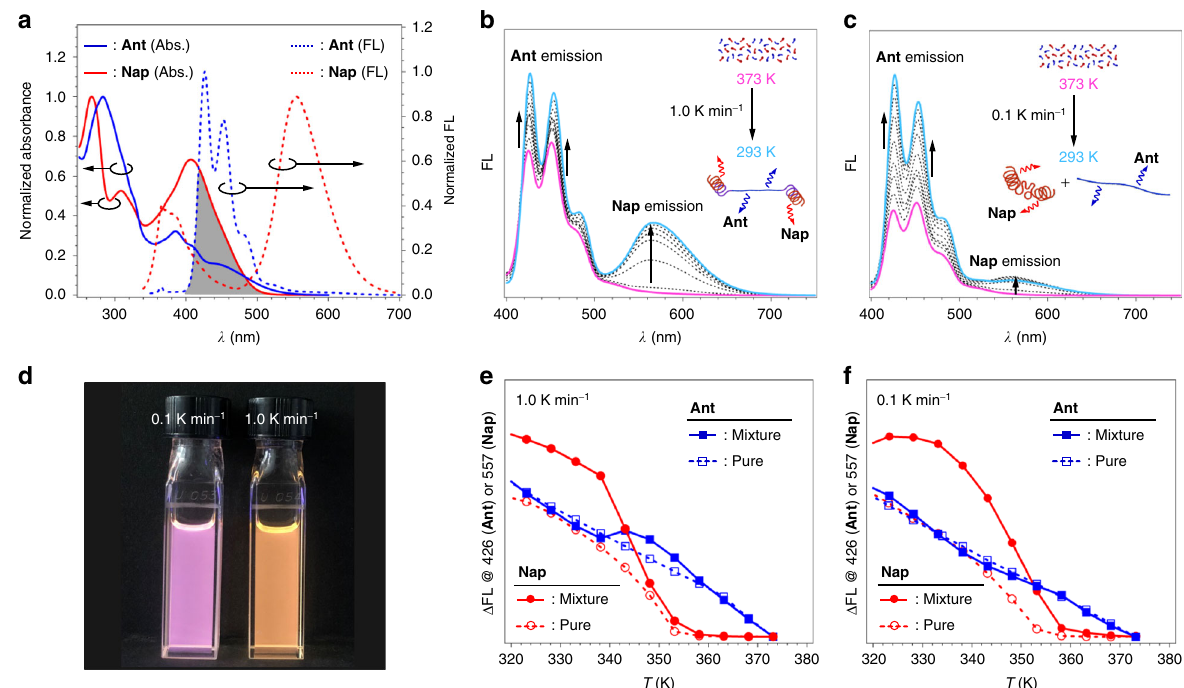
Fig. 4 Mechanistic studies on the gradient supramolecular copolymerization by fl uorescence spectroscopy. a Overlay of fl uorescence spectra and absorption spectra of Ant and Nap ( c = 1.0 × 10 − 5 M). Dotted curves: fl uorescence spectra of Ant (blue) and Nap (red) in MCH ( λ ex = 283 nm) measured after cooling from 373 to 293 K using a cooling rate of 1.0 K min − 1 . Solid curves: absorption spectra of Ant (blue) and Nap (red) in MCH measured after cooling from 373 to 293 K using a cooling rate of 1.0 K min − 1 . The gray area shows the overlap of the fl uorescence spectrum of Ant and absorption spectrum of Nap. b , c Temperature-dependent fl uorescence spectra of a 1:1.5 mixture of Ant ( c = 1.0 × 10 − 5 M) and Nap ( c = 1.5 × 10 − 5 M) upon cooling from 373 to 293 K using cooling rates of 1.0 K min − 1 ( b ) and 0.1 K min − 1 ( c ) ( λ ex = 330 nm). d Photograph of the emission of 1:1.5 mixtures prepared by cooling at 0.1 K min − 1 (left) and 1.0 K min − 1 (right). e , f Plot of the fl uorescence intensity change ( Δ FL) for Ant at 426 nm (blue) and Nap at 557 nm (red) as a function of the temperature upon cooling pure MCH solutions (open circles and squares with dashed lines) and the 1:1.5 mixure (closed circles and squares with solid lines) using a cooling rate of 1.0 K min − 1 ( e ) and 0.1 K min − 1 ( f